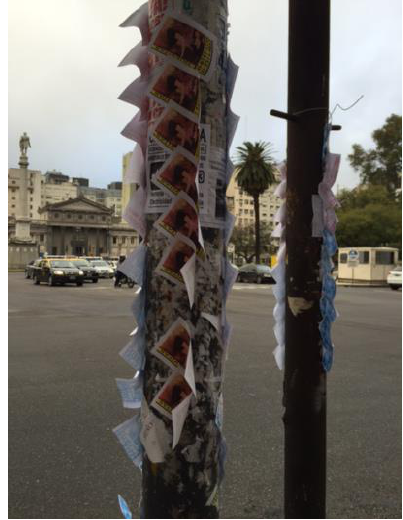
Figure 3. Papelitos advertising sex work. Photo by author.